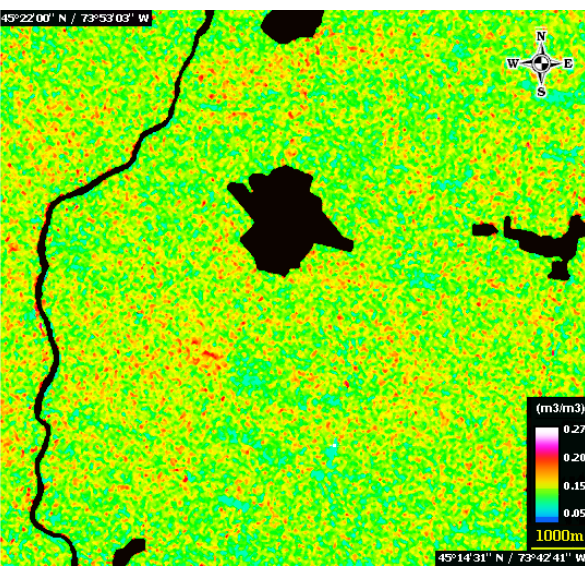
Fig. 11. rms height map at pixel scale.